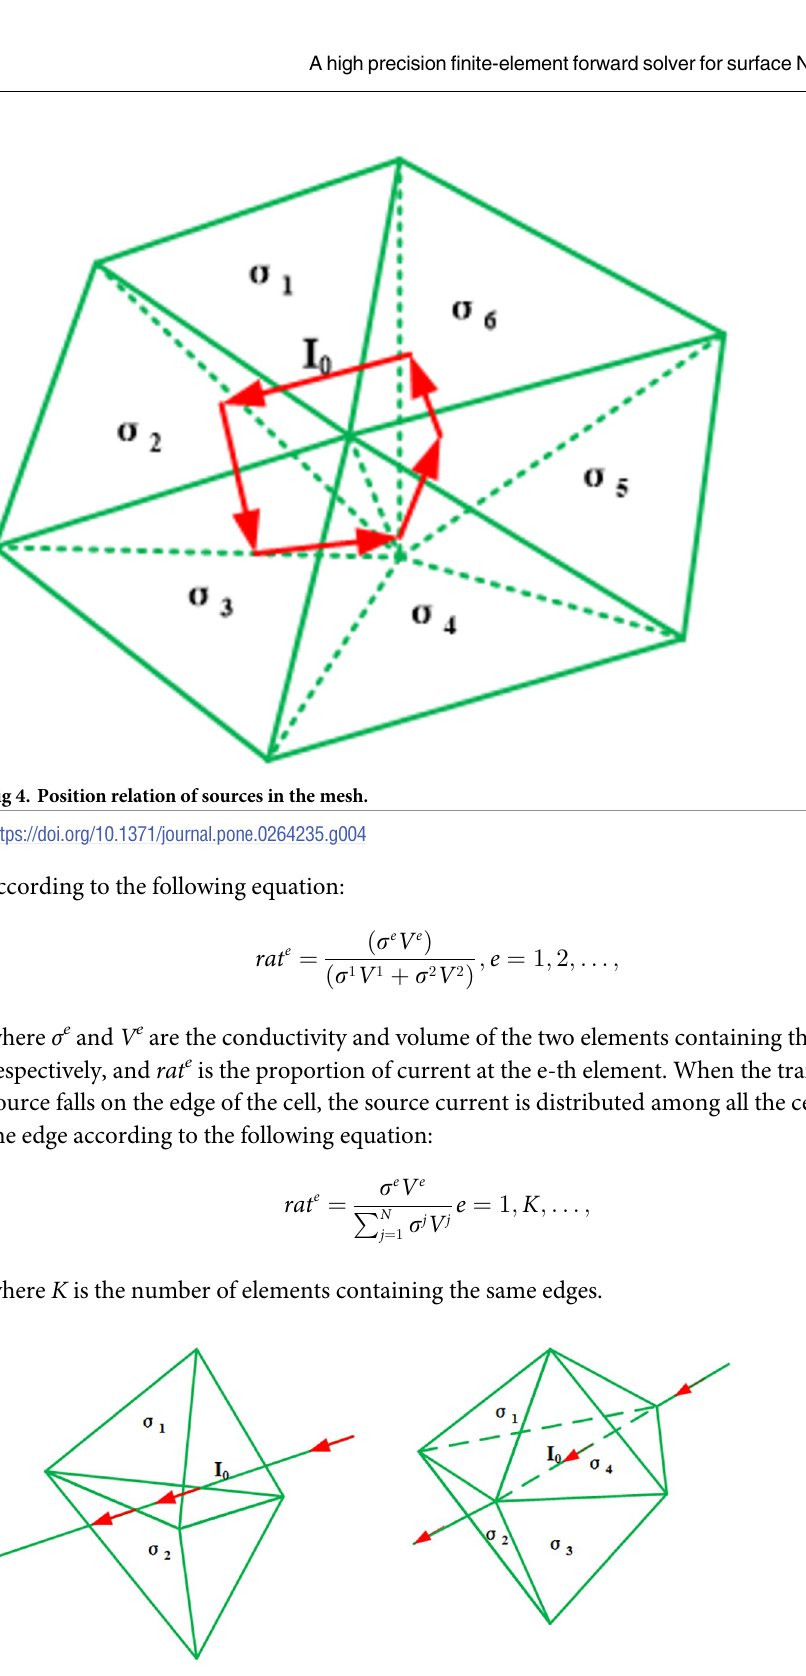
Fig 5. Contact relationships of the source with the (A) surface and (B) edge of the tetrahedral element.